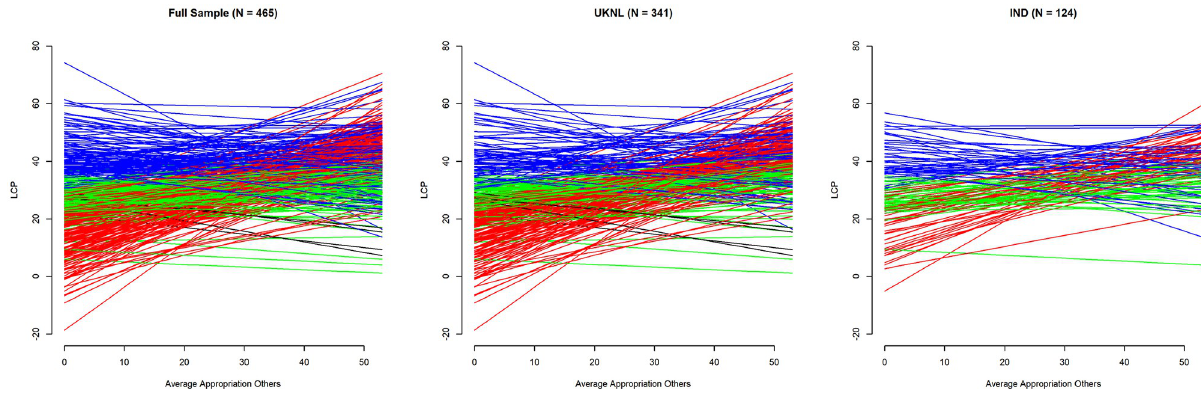
Fig 7. LCP (intercept & slope) by average appropriation of others (t-1)—types by colour.